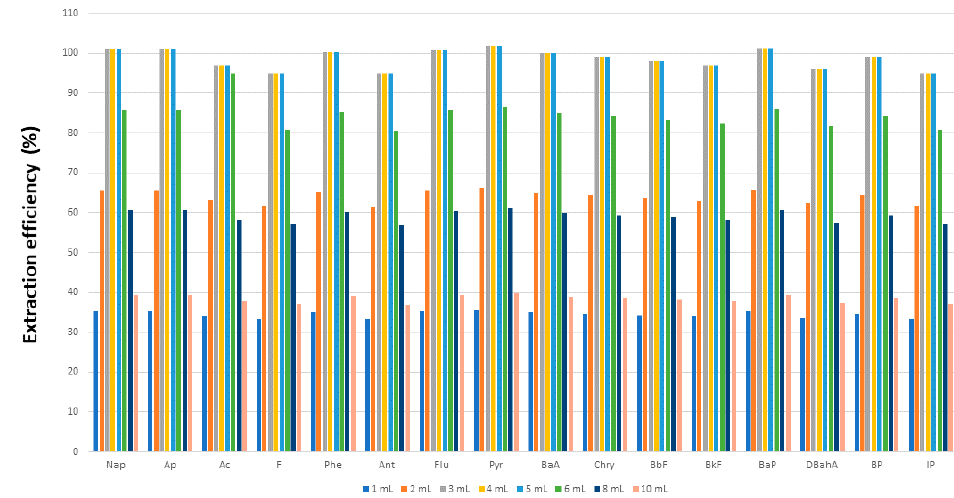
Figure 2. Influence of the volume of ethanol on the extraction of polycyclic aromatic hydrocarbons from dairy products.